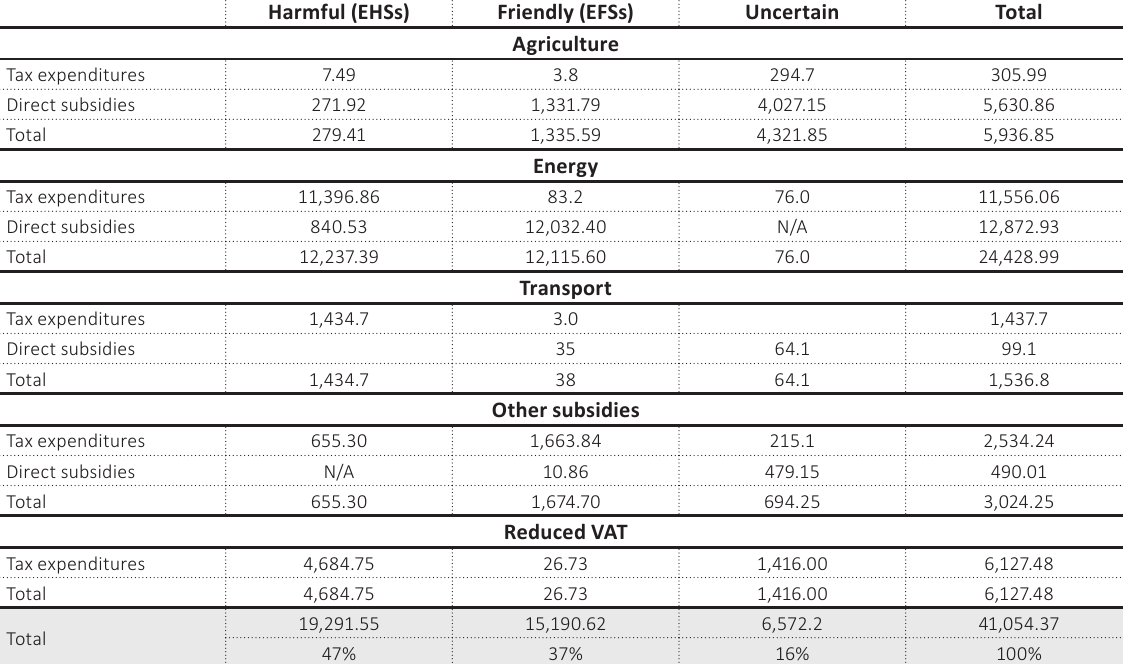
Table 2. Estimates of total amount of subsidies by sector and typology (2017, EUR